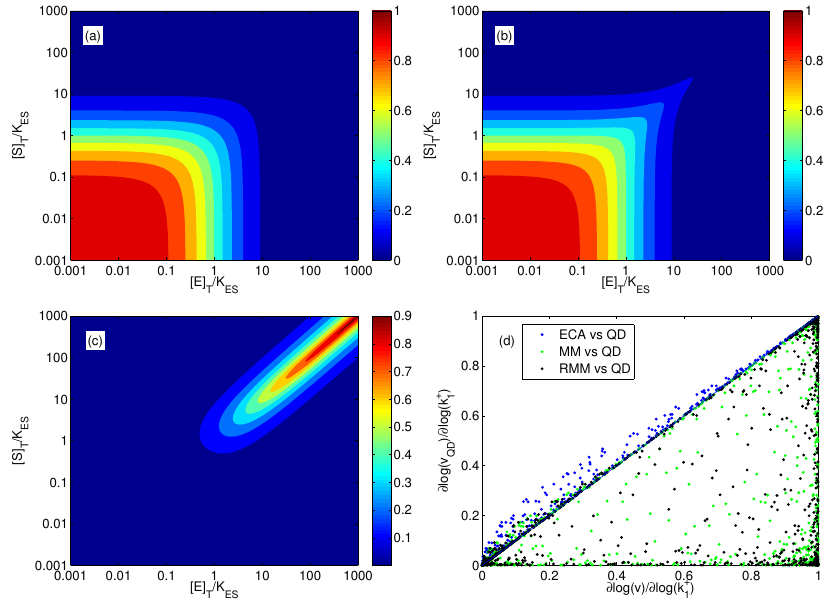
Figure 2. Similar to Fig. 1, but the sensitivity is evaluated against the intrinsic substrate affinity k +